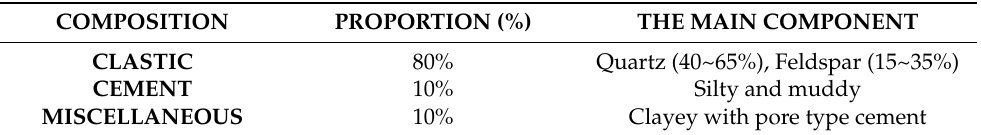
Table 3. Composition of the target